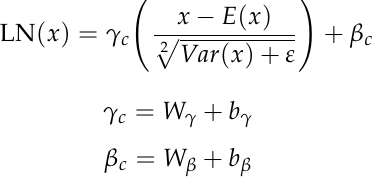
Figure 4. Conditional layer normalization structure.